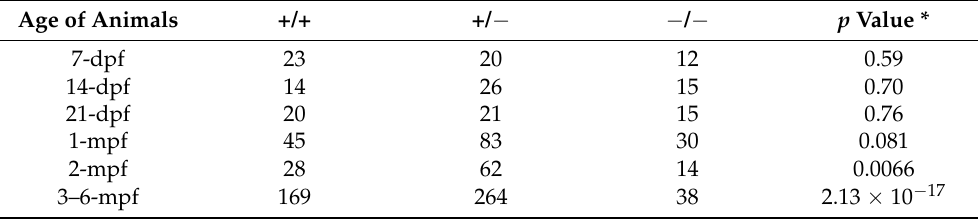
Table 1. Genotypes of animals from heterozygous crossings at 7-dpf to 6-mpf.